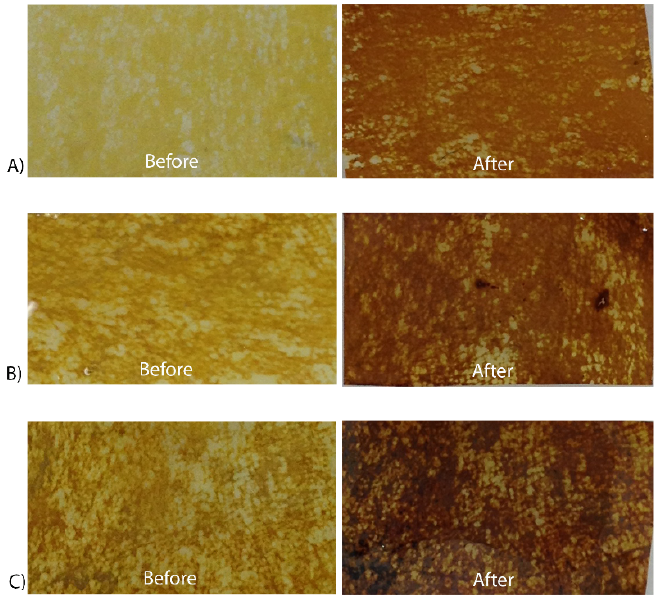
Figure 4. The surface color of membranes ( A ) M1, ( B ) M2 and ( C ) M3 before and after silver nanoparticle regeneration.